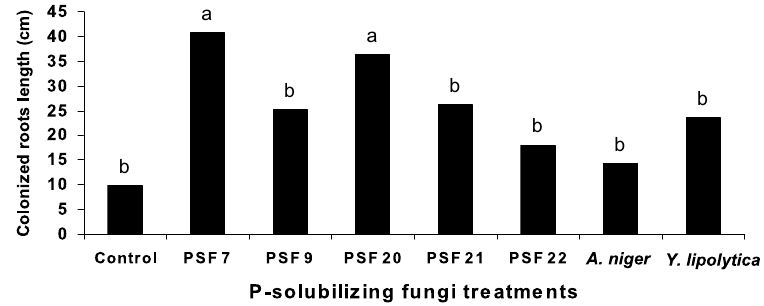
Fig. 4 – Mycorrhizal colonized root length of clover inoculated with P-solubilizing fungi from Paraty, Rio de Janeiro, Brazil (PSF 7, 9, 20, 21 and 22) and from Granada, Spain ( A. niger and Y. lipolytica ). (Lower-case letters compare PSF treatments by the Scott-Knott test ( p ≤ 0 . 05 )